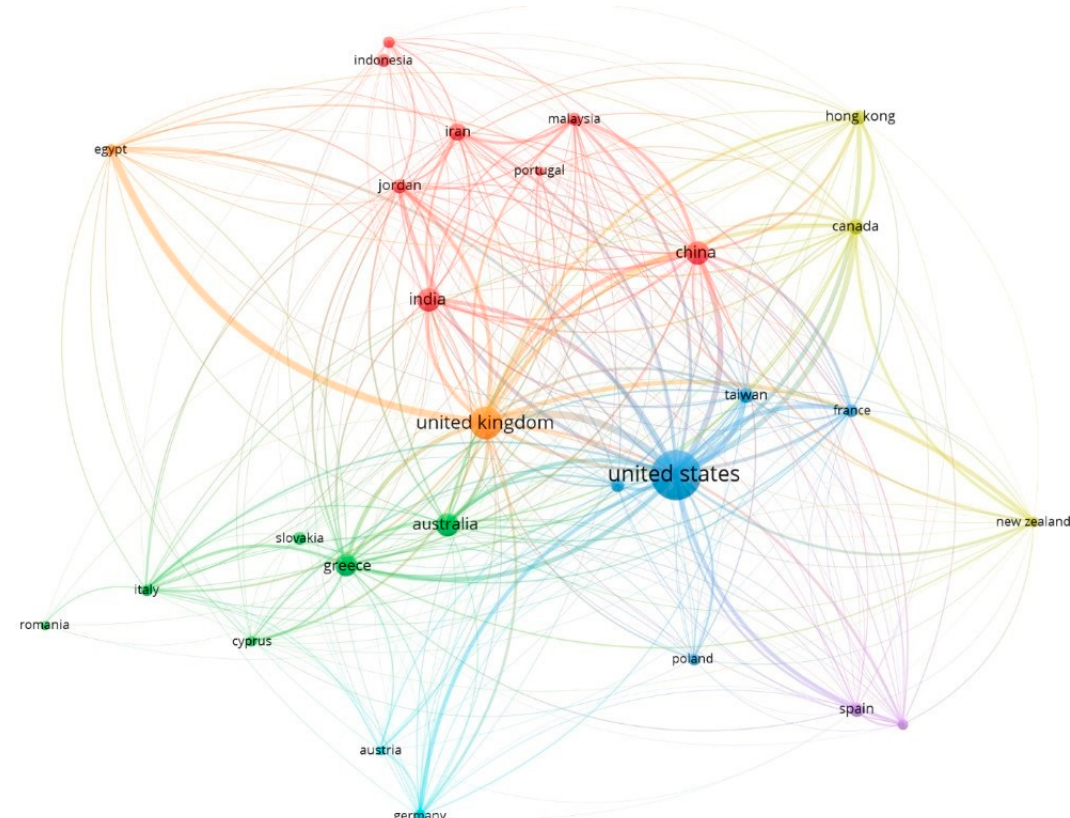
Figure 2. Bibliographic coupling of countries.